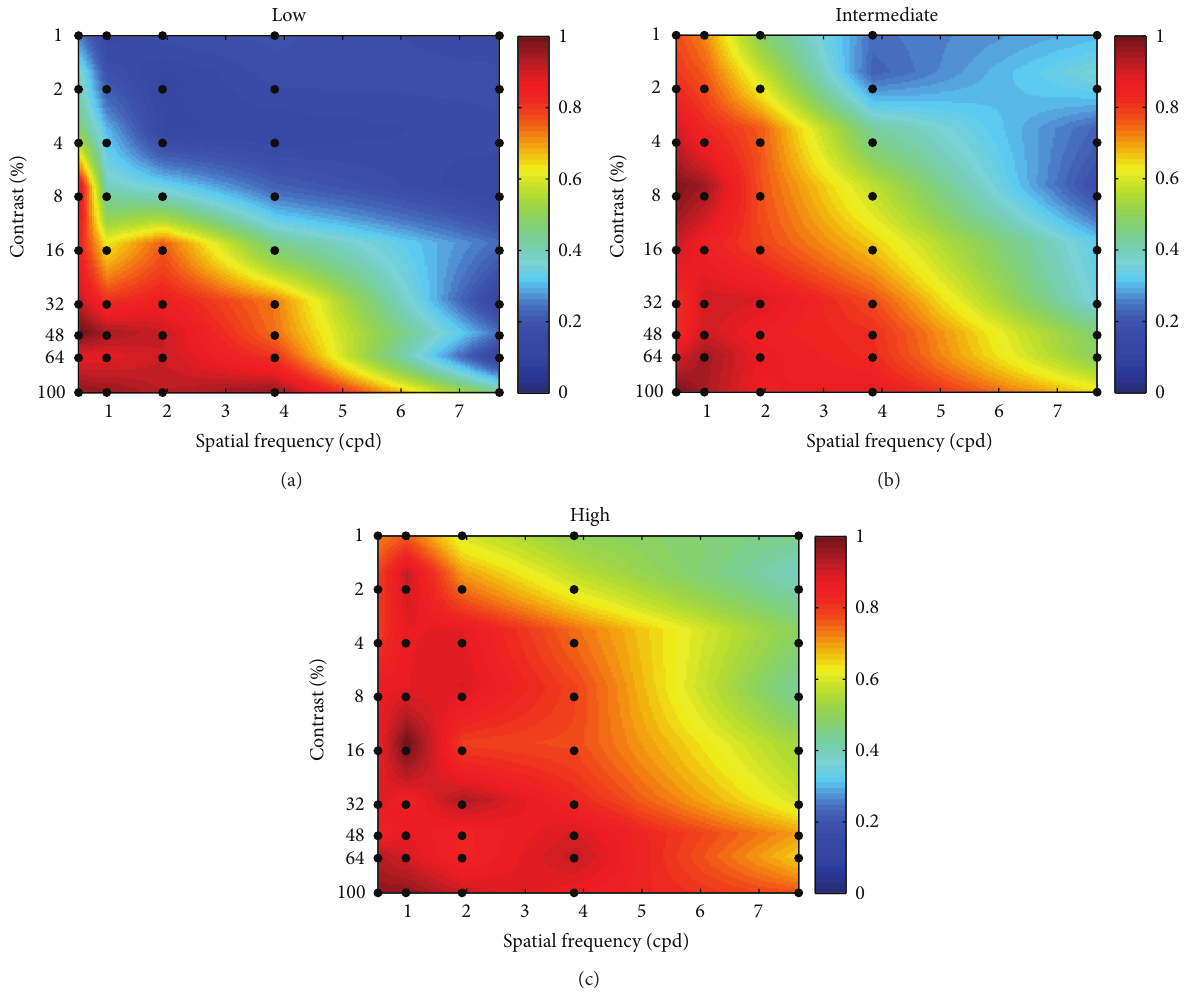
Figure 2: For each of the three groups (low, intermediate, or high visual acuity), the color reflects the averaged normalized GFR gains at 45 combinations of contrast and spatial frequency (indicated by black dots). The space between the measured points is linearly interpolated.